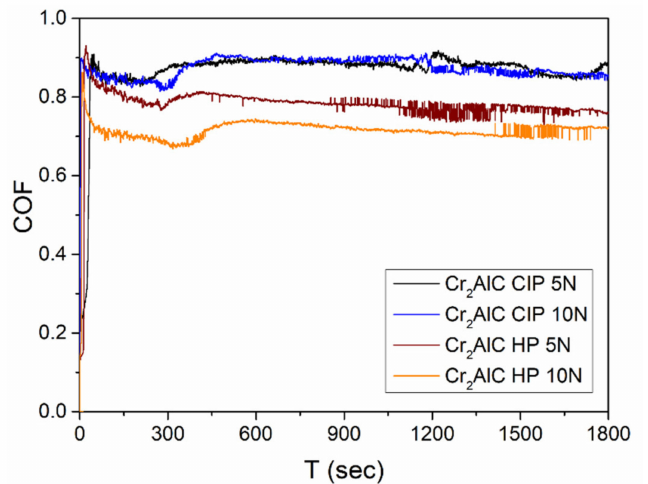
Figure 12. The coefficients of friction of the cold isostatic pressing and sintering (CIP) and hot-pressed (HP) samples during the reciprocating-sliding test with a load of 5 and 10 N of the Cr 2 AlC MAX